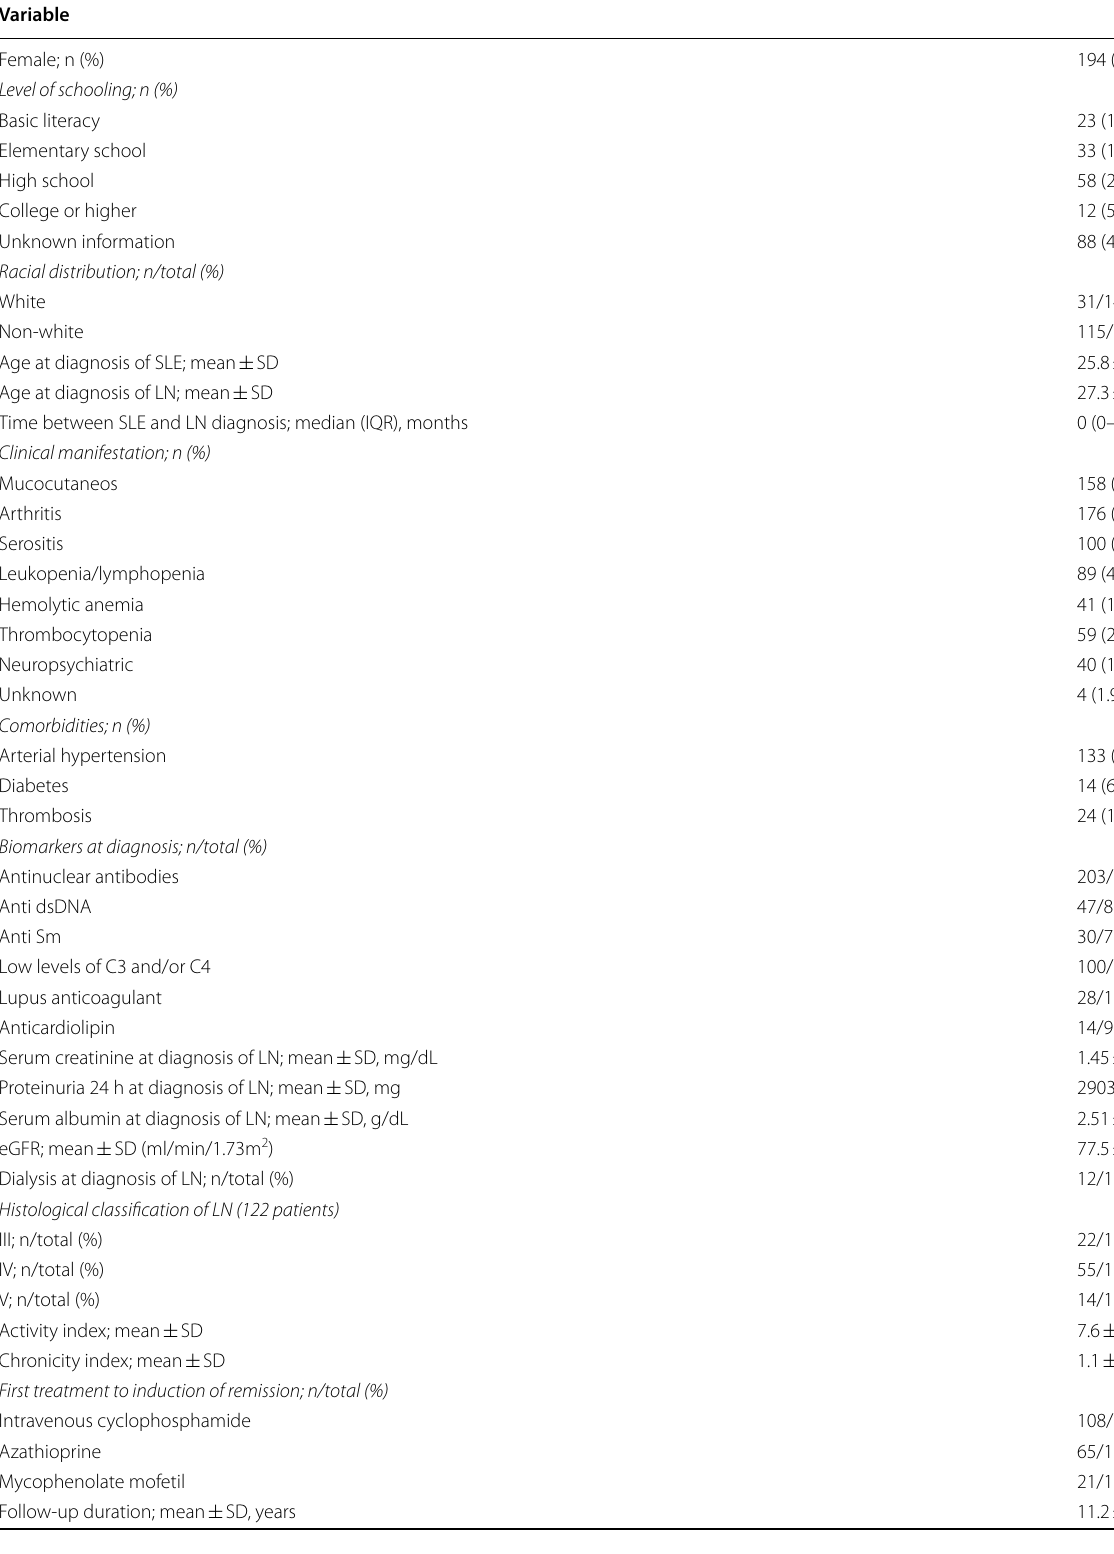
Table 1 Demographics and disease related features in 214 patients with lupus